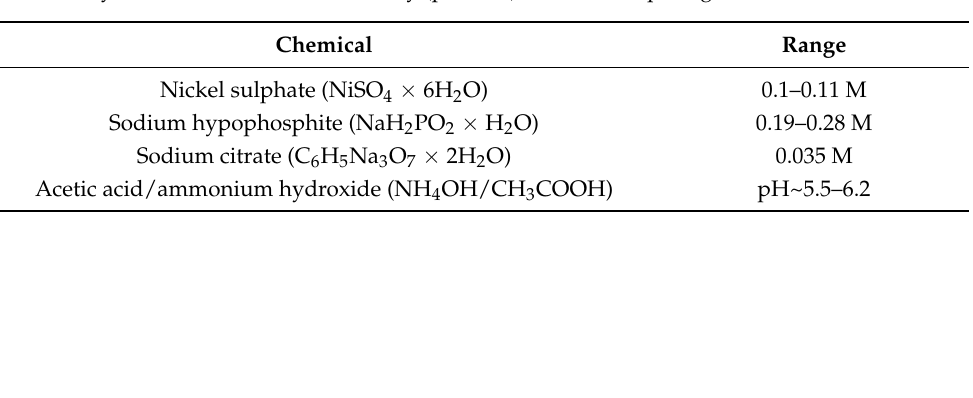
Table 2. Key Chemicals and Their Quantity (per liter) Used for Preparing ENP